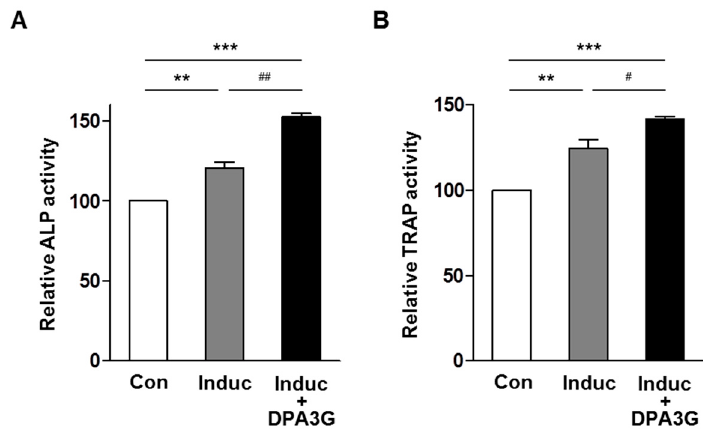
Figure 5. Effects of (1 ′ R ,2 ′ S ,5 ′ R ,8 ′ S ,2 ′ Z ,4 ′ E )-dihydrophaseic acid 3 ′ - O - β - D -glucopyranoside (DPA3G) on osteoblast and osteoclast differentiation in the co-culture of preosteoblasts and primary monocytes. Co-cultured MC3T3-E1 and primary monocyte cells were treated with osteoblast differentiation reagents, ascorbic acid, and β -glycerophosphate, and then co-treated with 5 μ g/mL of DPA3G fraction for 5 days. Alkaline phosphatase (ALP) activity ( A ) and tartrate-resistant acid phosphatase (TRAP) activity ( B ) were assessed in the co-culture cells. Con: non-induction control of osteoblast differentiation. Induc: induction of osteoblast differentiation with 50 μ g/mL of ascorbic acid and 10 mM of β -glycerophosphate. **, ***: p < 0.01, p < 0.001 vs. Control, and # , ## : p < 0.05, p < 0.01 vs. Induction (Tukey’s HSD post hoc test, ANOVA). All of the experiments were repeated three times.